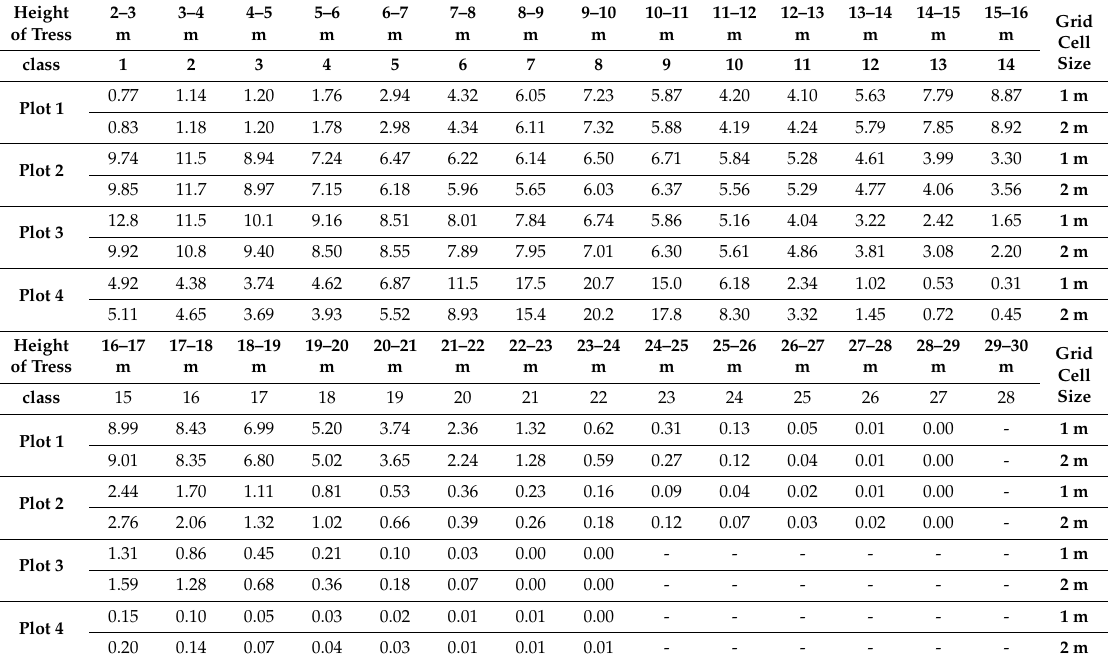
Table 1. The forest cover height structure derived from historical stereometric photographs. The data in the table represent the share of individual classes in the forest cover structure. The table contains the percentage of classes for plots developed for a grid cell size of 1 m and 2 m.